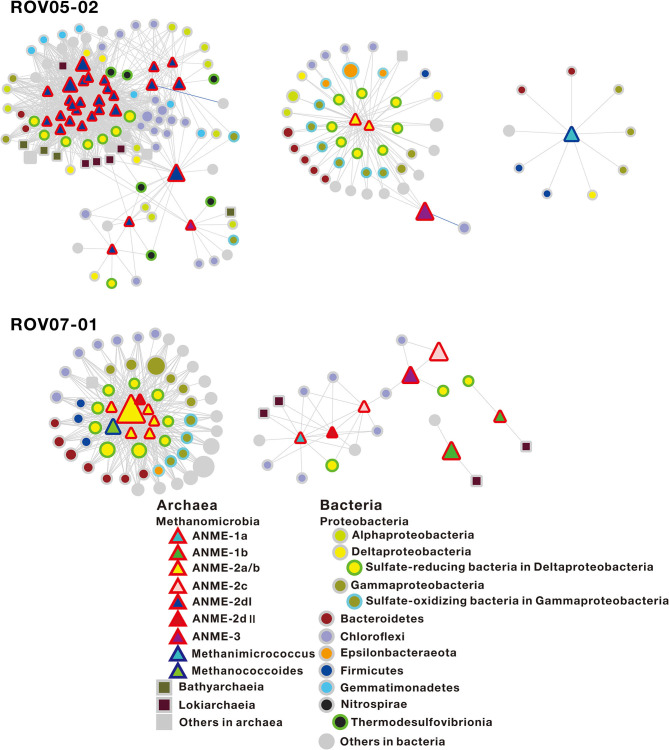
Sub-network co-occurrence patterns regarding the relationship of the methane-metabolizing archaea with other microbial taxa in the sediments of ROV05-02 and ROV07-01 in the cold seeps. The sub-network of the sediments of ROV07-02 is not presented, as only one node belongs to methane-metabolizing archaea. The red-sided triangles, blue-sided triangles, squares, and circles in the network represent ANMEs, archaeal methanotrophs, other archaea, and bacteria, respectively. Node size indicates the relative abundance of OTUs. Edges represent co-occurrence relationships between nodes (coefficient >0.9 or < −0.9, P ≤ 0.01). Gray edges and blue edges represent positive and negative relationships, respectively. The specific OTUs correlated with ANME-2dI and ANME-2a/b are shown in Supplementary Table 5.